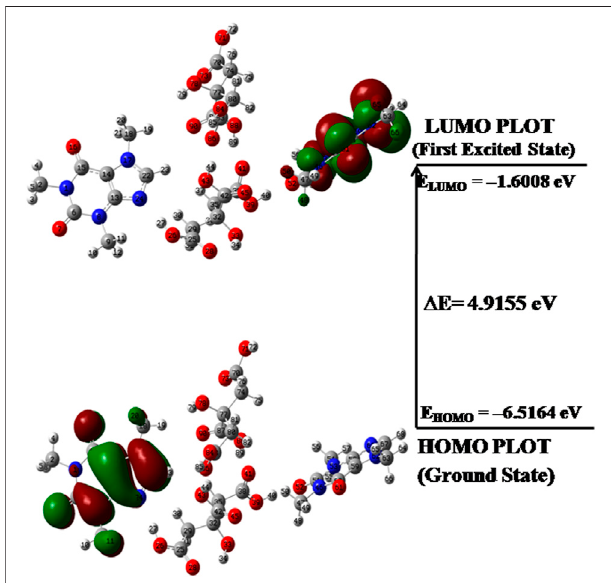
FIGURE 6 | HOMO-LUMO plot of dimer model of cocrystal with orbital involved in electronic